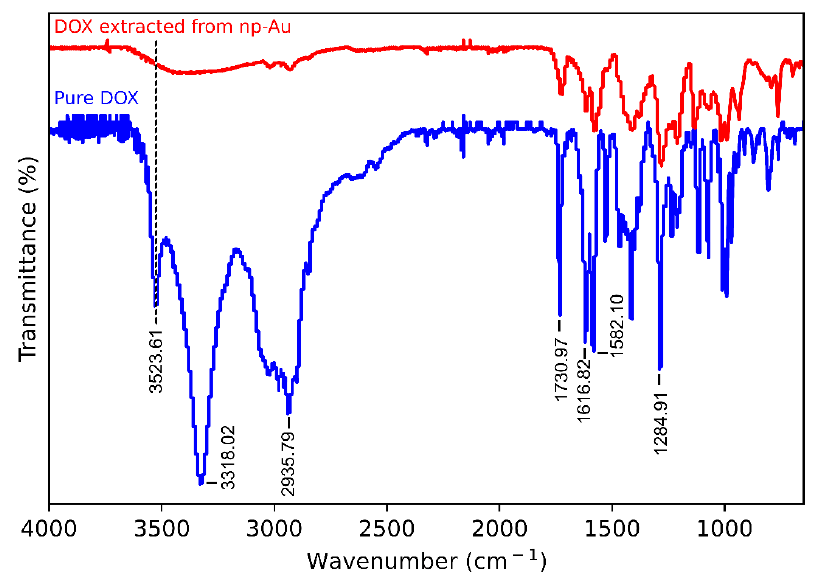
Figure 7. Typical atomic force microscopy (AFM) topographic images of np-Au before ( A ) and after DOX loading ( B ) and their corresponding 3D view and height distribution profiles on the right.